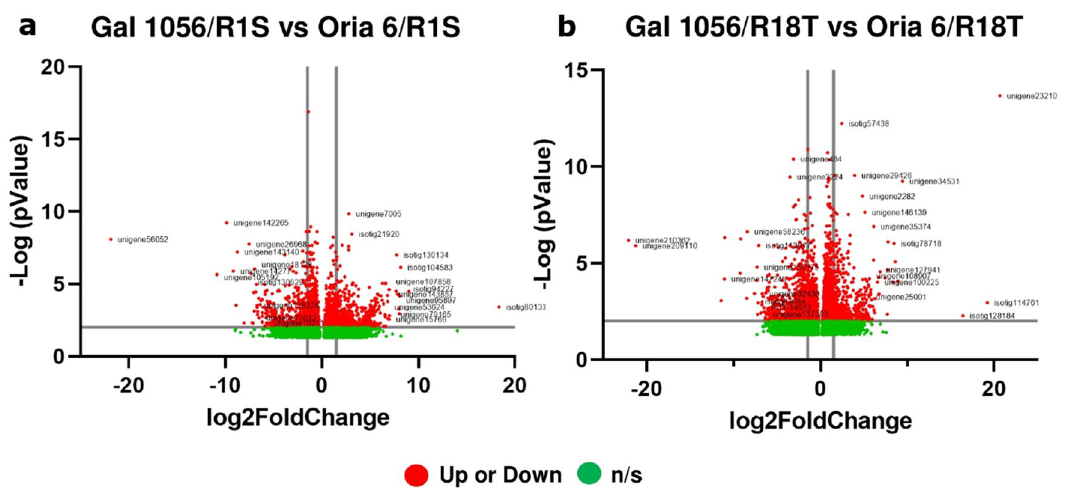
Figure 7. Volcano plots of differential expression profiles comparing genes differentially expressed in needle scions of ( a ) Gal 1056/R1S versus Oria 6/R1S and ( b ) Gal 1056/R18T versus Oria 6/R18Tgrafts (up or down: significantly upregulated or downregulated genes [Log2FC ≤ − 1.5 and Log2FC ≥ 1.5]; n/s: no significant genes). Details of the genes have been given in Supplementary Table 6 and Supplementary Table 7. P values ( P < 0.05) were calculated according to the Wald